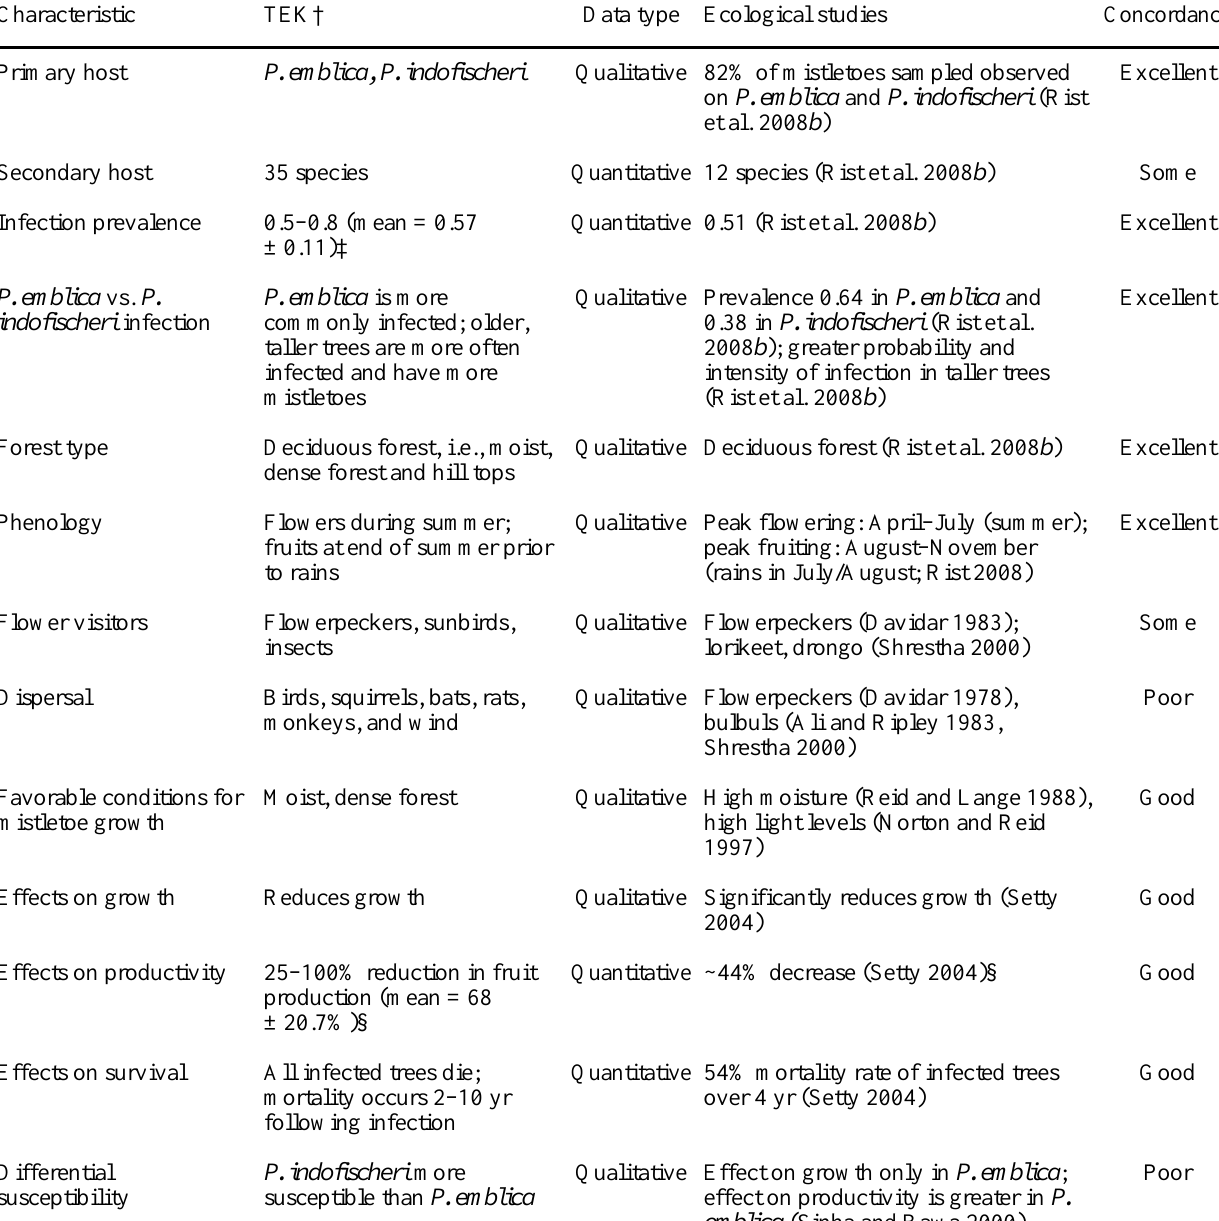
Table 2. Summary of harvester and scientific knowledge about mistletoe ecology and distribution and the effects of mistletoe infection on